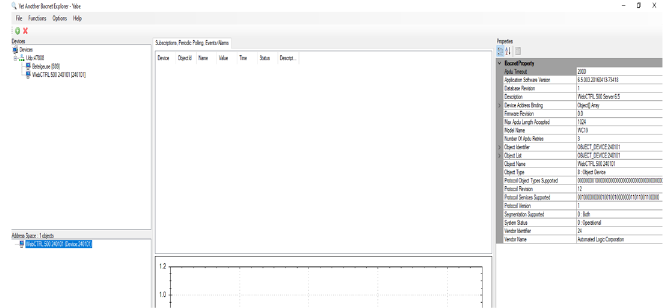
Figure 15. Communication between WebCTRL and our data server.